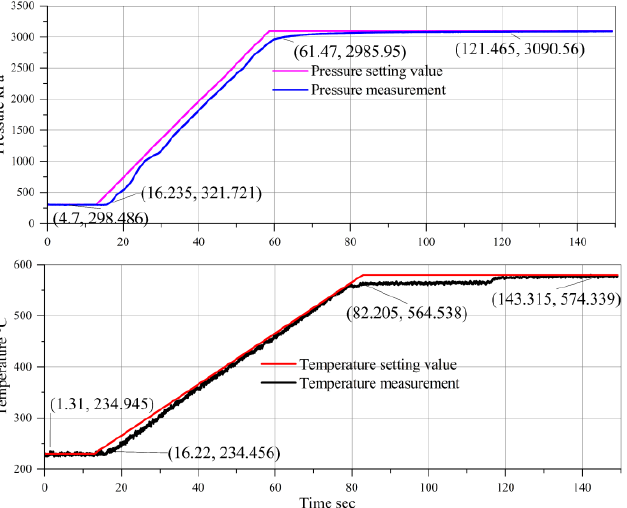
Figure 10. Compressor bleed air simulation of test piece one under the rise rates of 50 kPa/s and 5 °C/s.